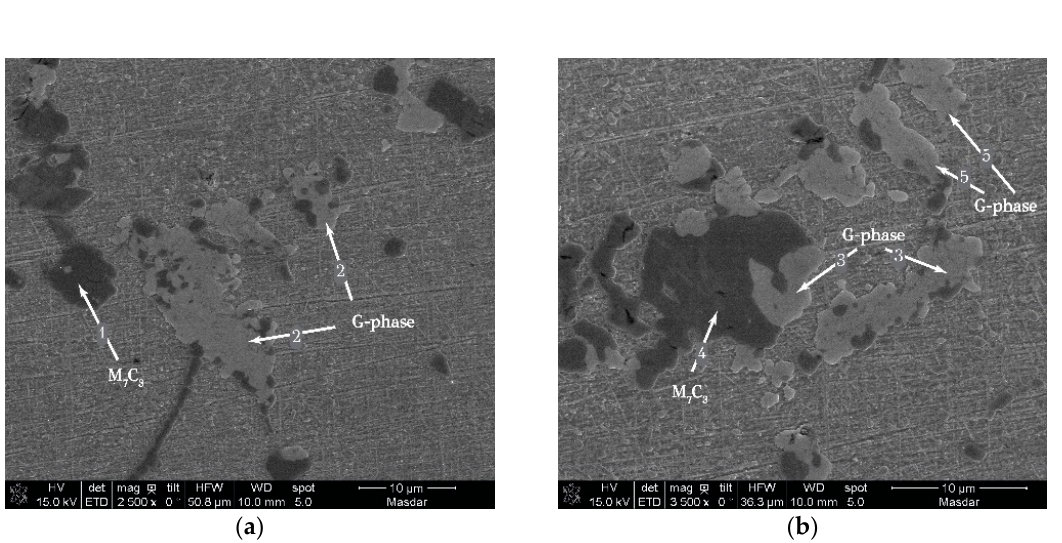
Figure 5. SEM images, ( a , b ), depicting M 7 C 3 carbides and G-phase in condition M. Numbers indicate EDX composition analysis in Table